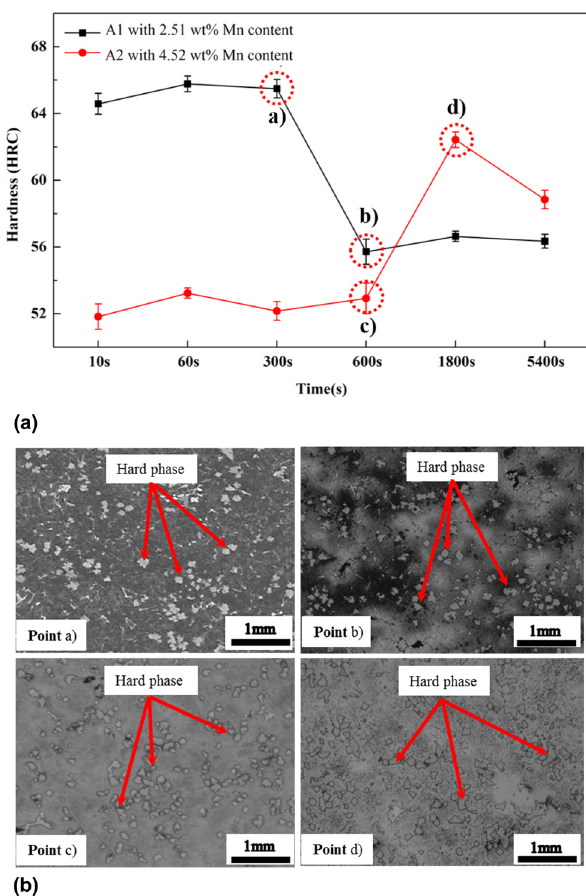
Figure 7: Hardness and microstructures of alloys A1 and A2 with different carbon partition times. ( a ) Hardness change of alloys A1 and A2 with different carbon partition times. ( b ) Metallographic structure of alloys A1 and A2 with different carbon partition times.